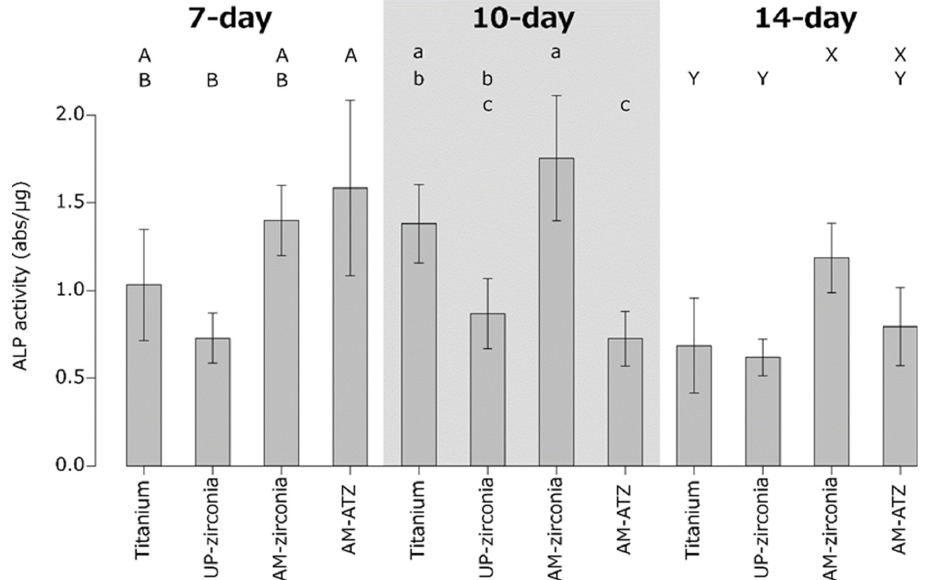
Figure 4. Alkaline phosphatase ( ALP) activity of MC3T3E-1 cells on each material at 7, 10, and 14 days. Identical letters indicate no statistical difference. 14 days. Identical letters indicate no statistical